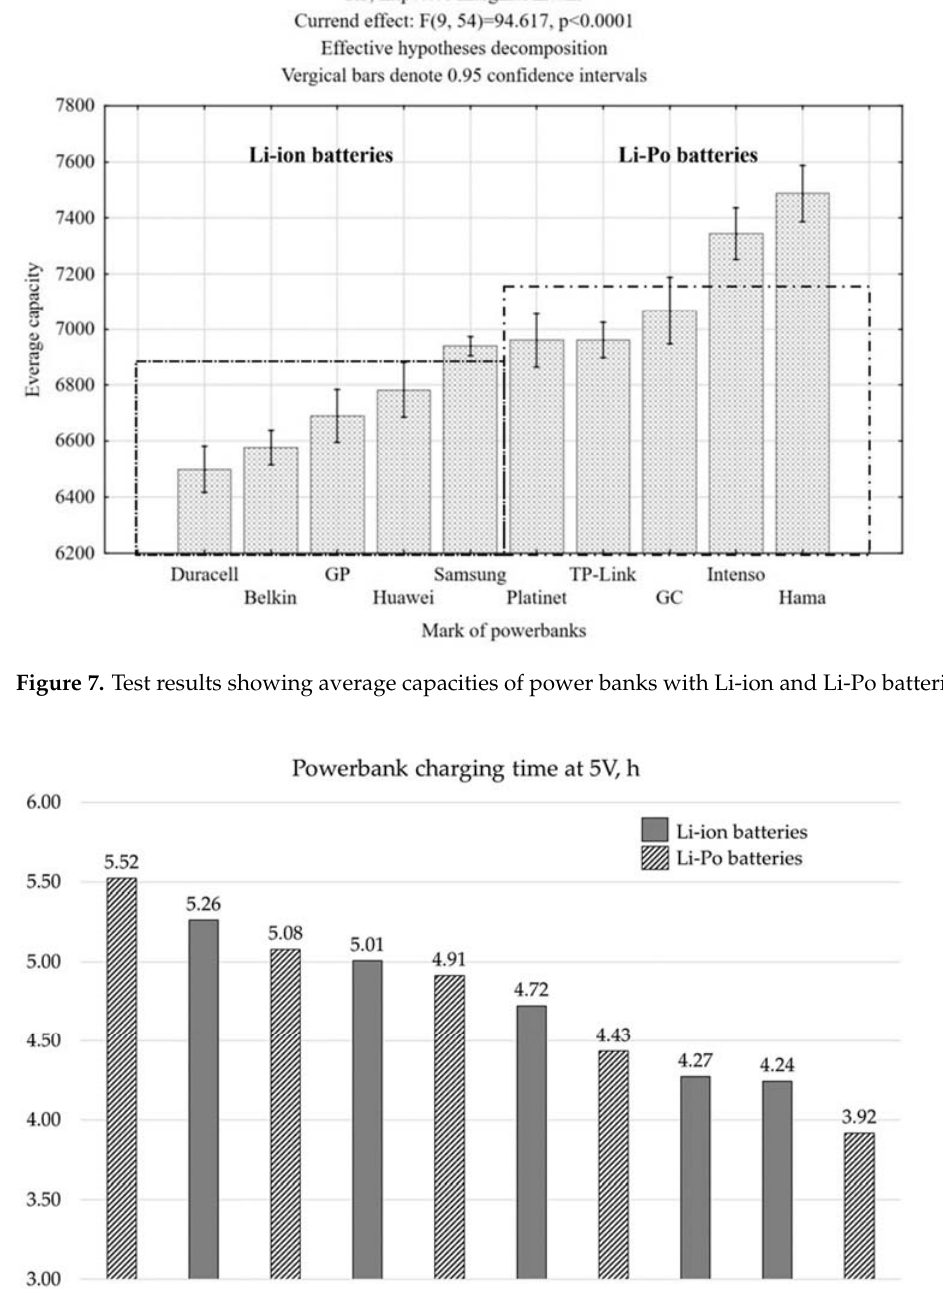
Figure 9. Capacity in mAh measured with 9 V quick charging for power banks offering such a function.